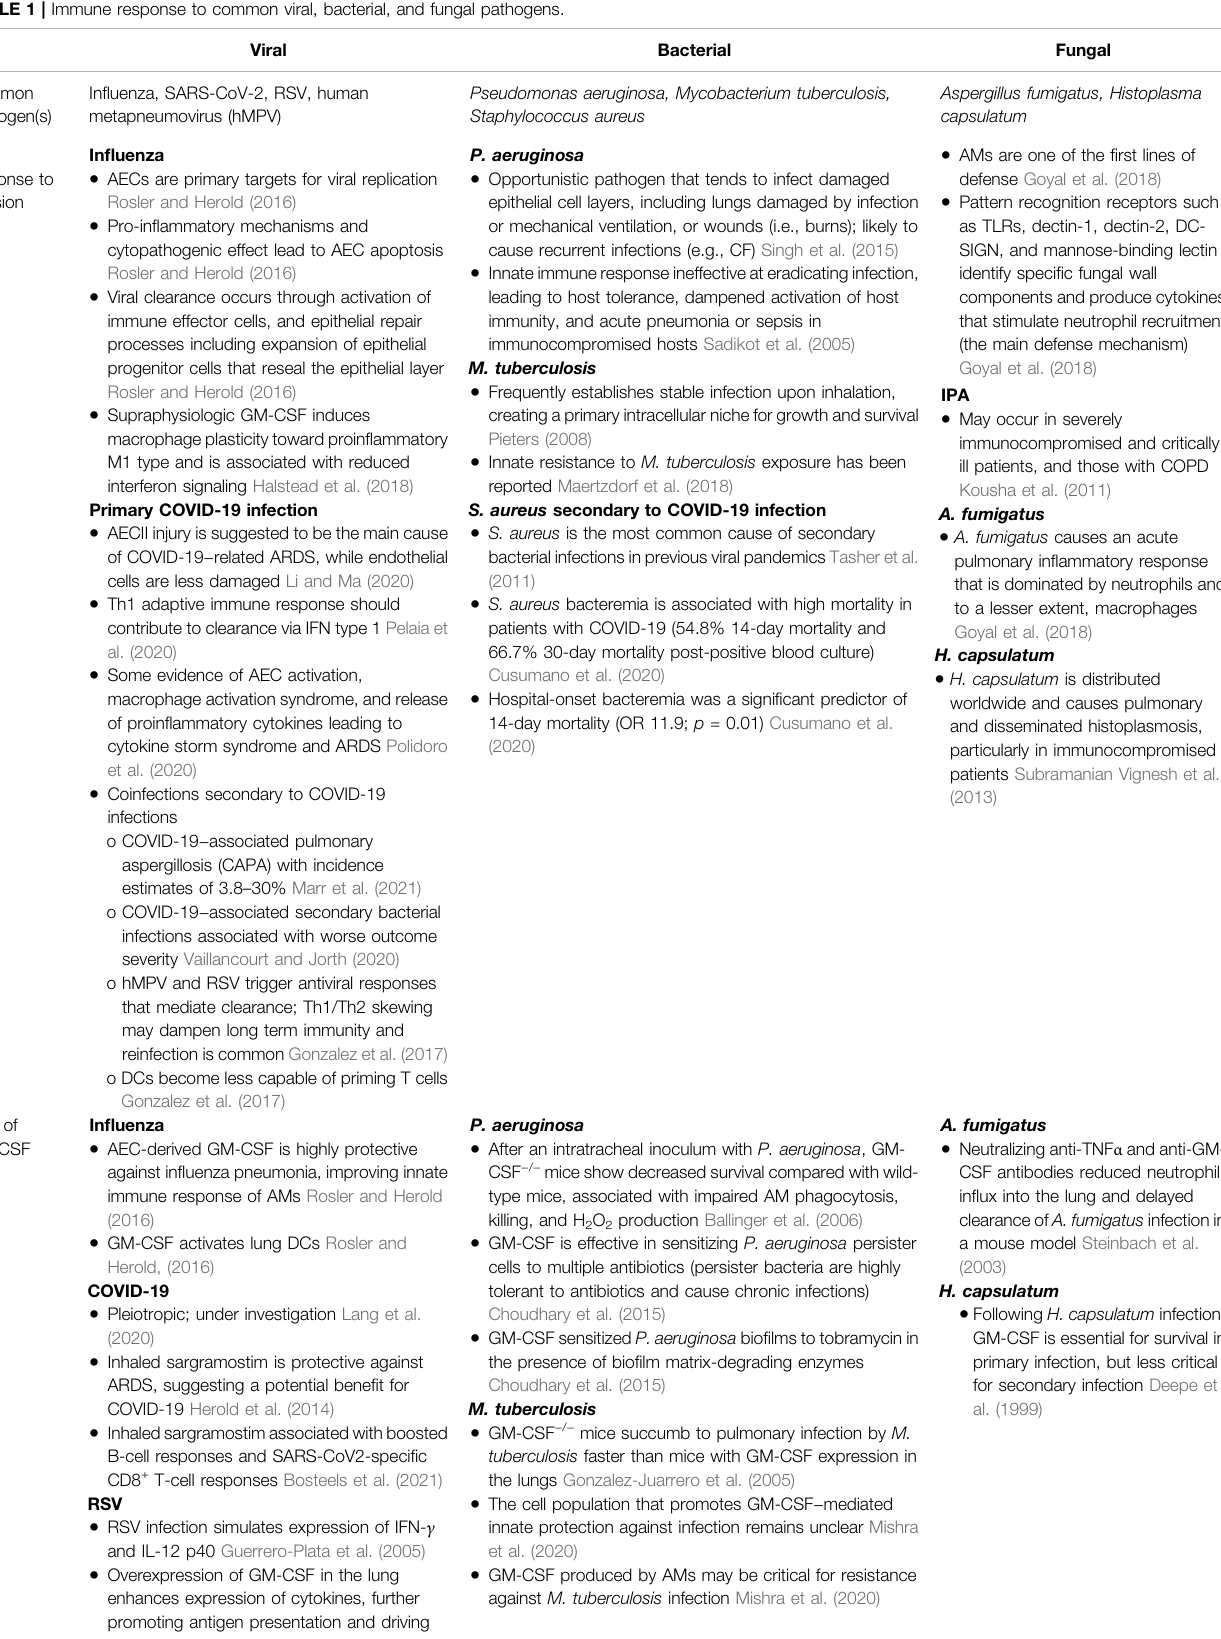
TABLE 1 | Immune response to common viral, bacterial, and fungal pathogens. Viral Bacterial